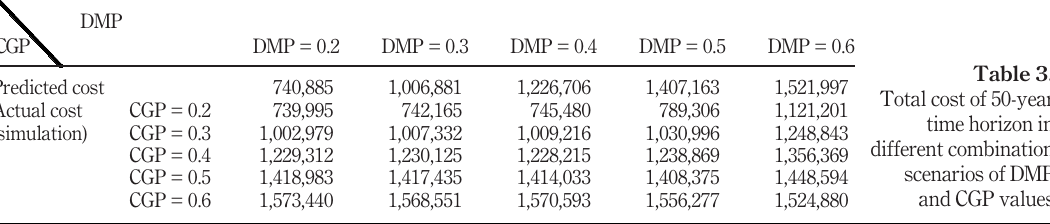
Table 3. Total cost of